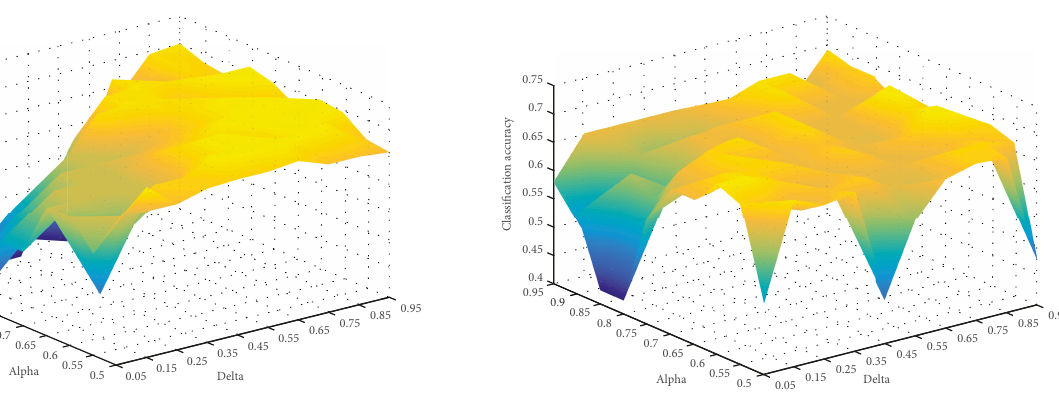
Figure 3: Classi fi cation accuracy with δ and α on glass.